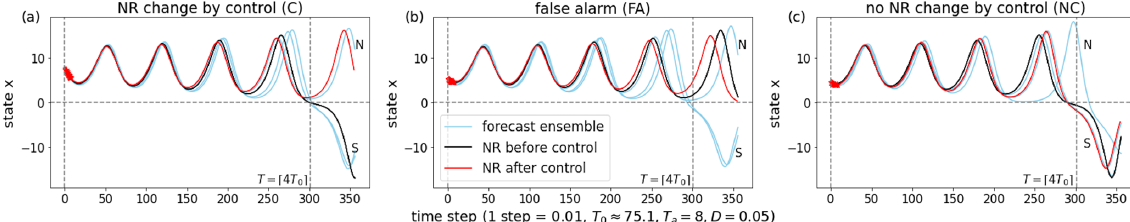
Figure 2. Control cases with T = (cid:100) 4 T 0 (cid:101) and D = 0 . 05 for (a) NR changed (C), (b) false alarm (FA), and (c) NR unchanged (NC). Red ticks at the beginning ( t = 1,...,7) show addition of perturbations to the